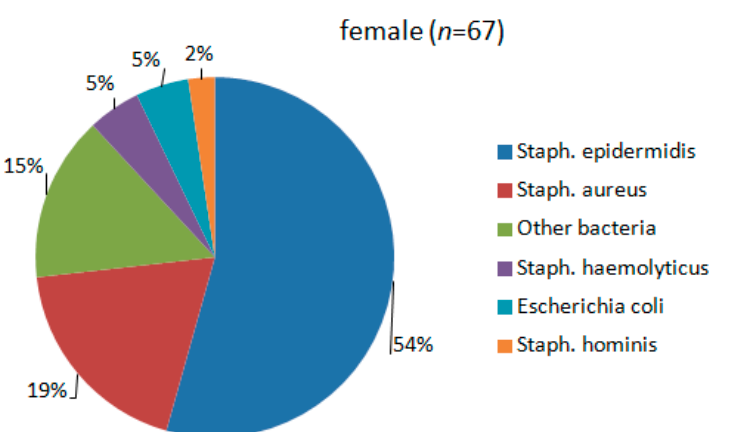
Figure 3. Distribution of pathogens in male patients with DSWI.